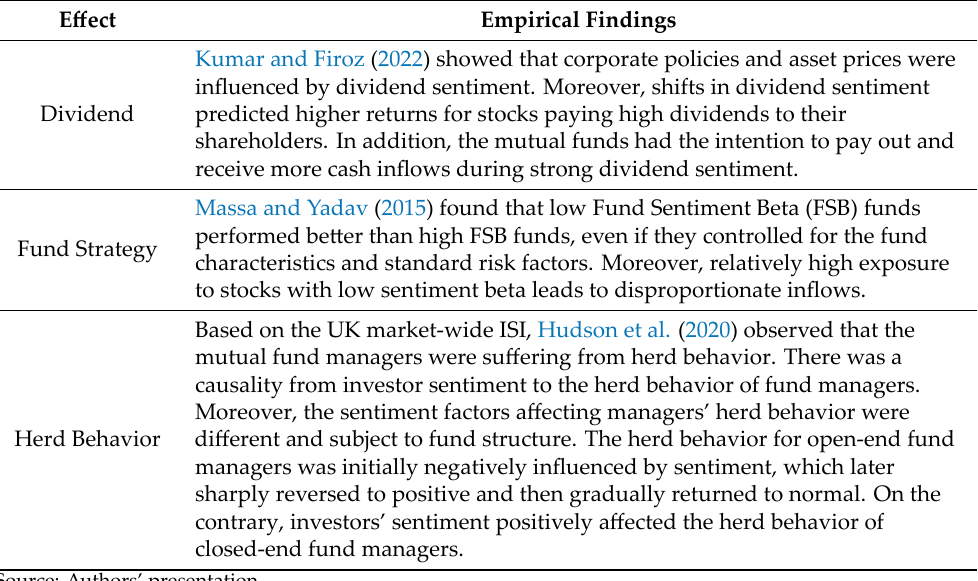
Table 5. Sentiment and mutual fund market.